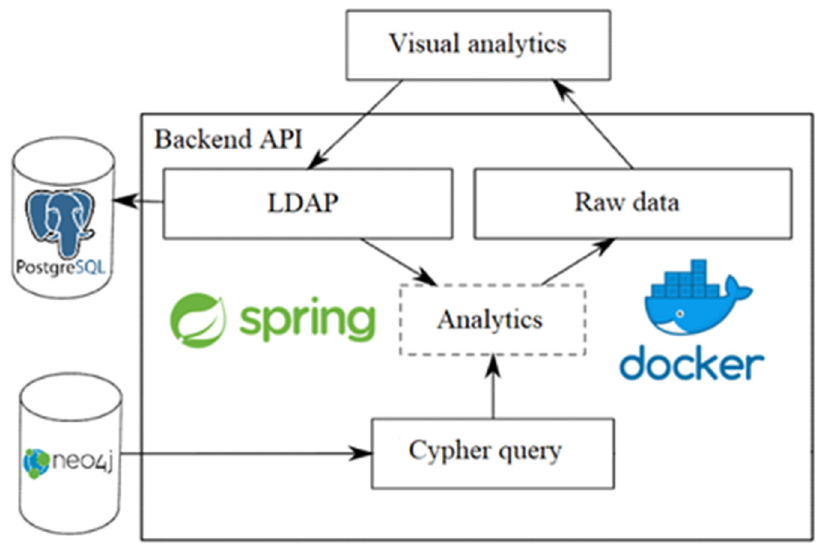
Figure 1. Infrastructure of the proposed STALITA investigation platform.